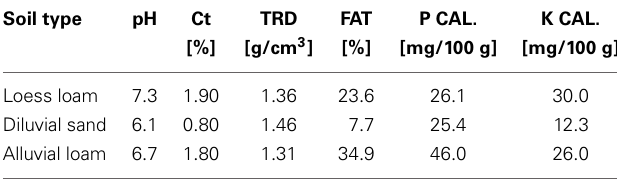
Table 1 | Characteristics of the field soils used for the